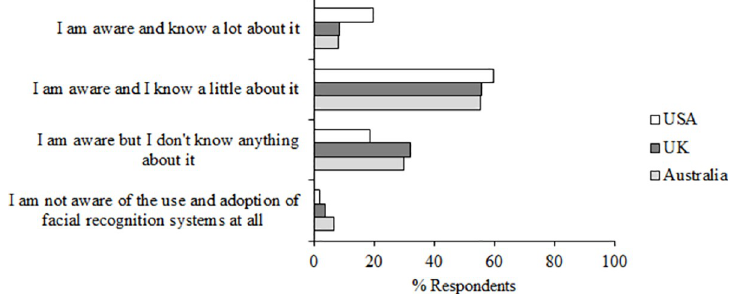
Fig 5. Question 4 data. Responses to question 4 “How aware are you of the use and adoption of facial recognition systems in your